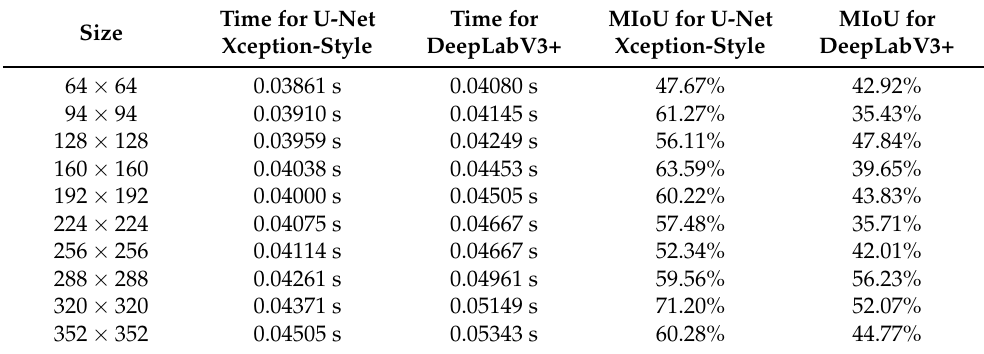
Table 3. Comparison with different input sizes.